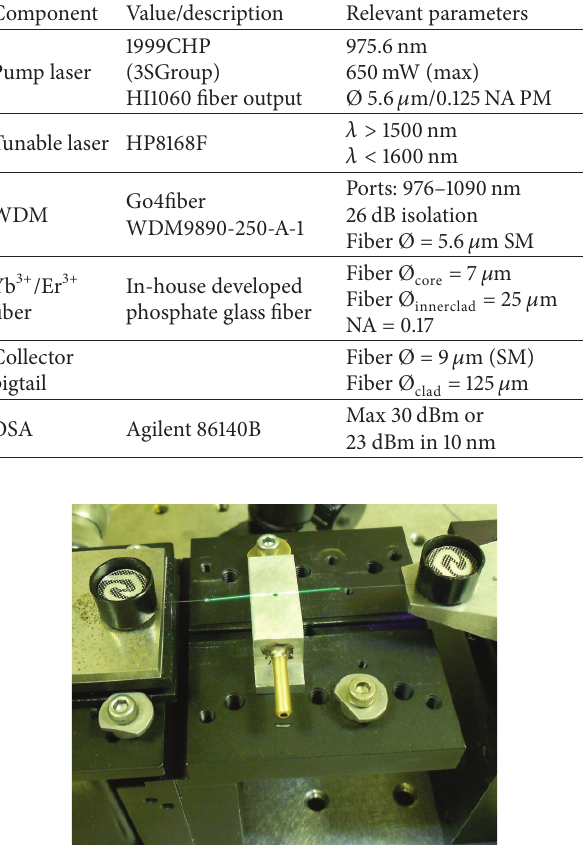
Figure 1: A detailed view of the fabricated amplifier